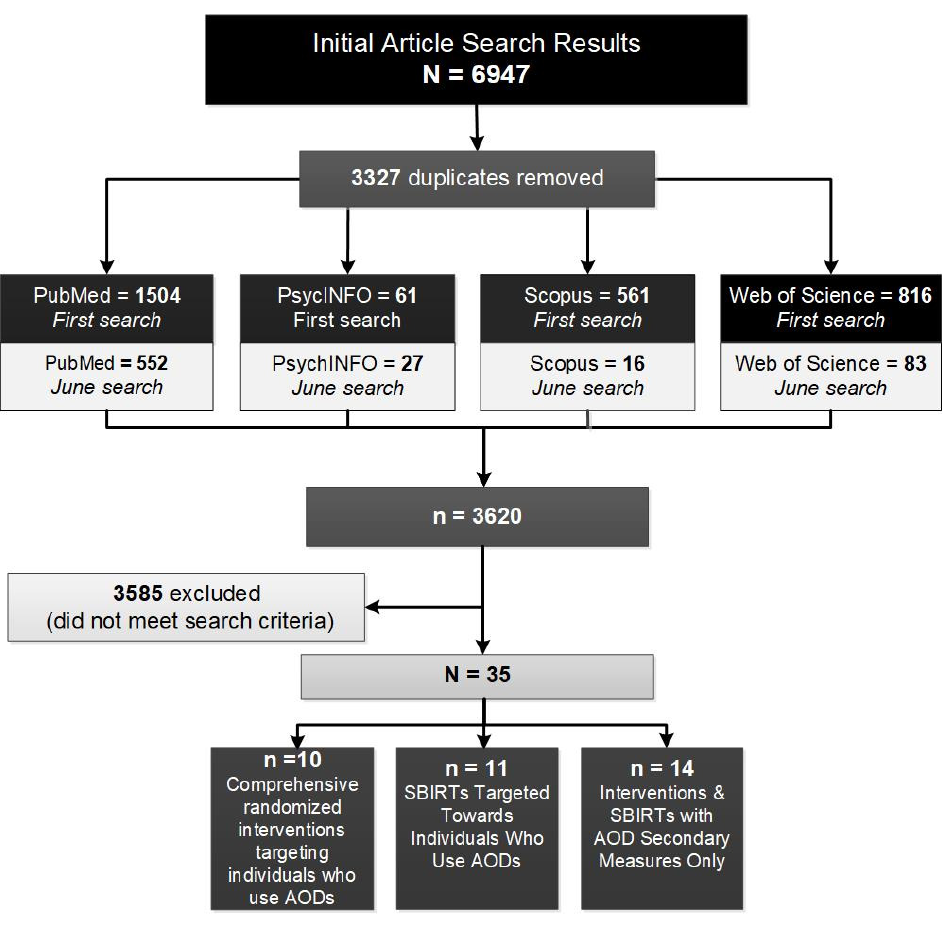
Figure 1. Search